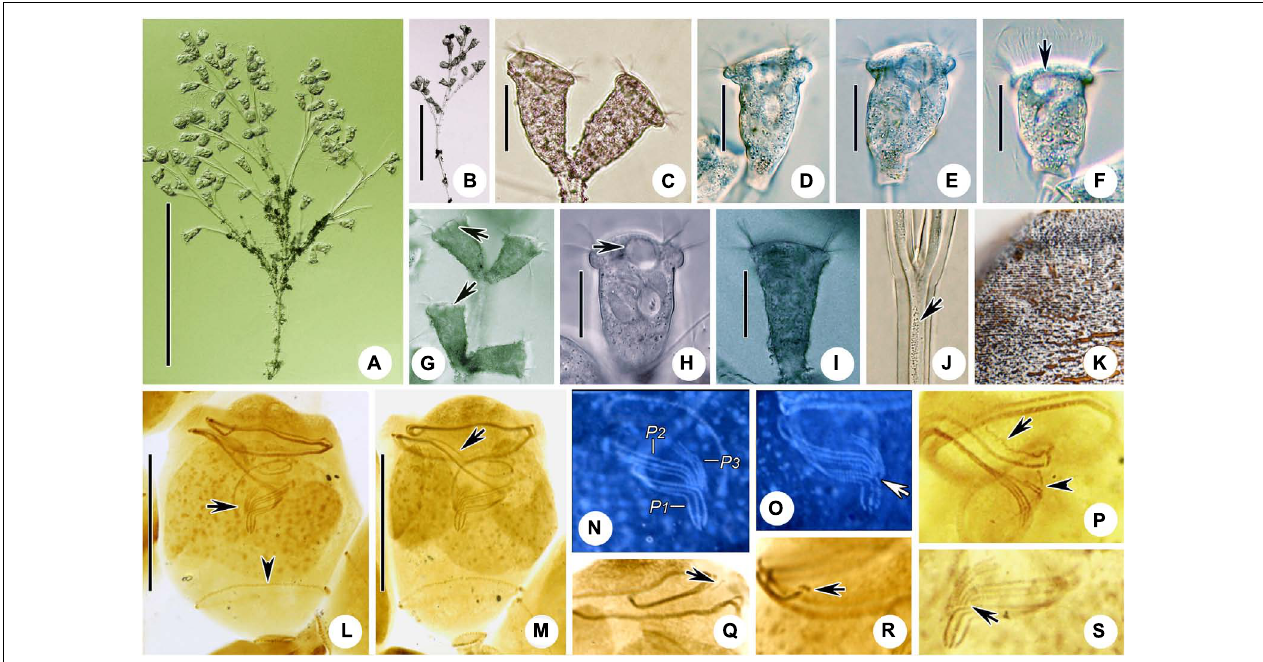
FIGURE 5 | Photomicrographs of Zoothamnium hentscheli in vivo (A–J) , after “dry” silver nitrate staining (K) , and after protargol staining (L–S) . (A) A mature colony. (B) A developing colony. (C–I) Different zooids showing the shape variation; arrows mark the contractile vacuole. (J) Detail of stalk; arrow marks the spasmoneme. (K) Silverline system. (L,M) Two protargol-stained zooids showing the ciliature; arrow in panel (L) marks the P3, arrowhead in panel (L) marks the trochal band, and arrow in panel (M) marks the germinal kinety. (N,O) Infundibular polykineties 1–3 (P1–3) (image processed by the reverse function via Photoshop); arrow marks the adstomal end of P3. (P–S) Part of the oral ciliature; arrow in panel (P) marks the germinal kinety, arrowhead in panel (P) marks the abstomal end of P2, arrow in panel (Q) marks epistomial membrane 1, arrow in panel (R) marks epistomial membrane 2, and arrow in panel (S) marks the adstomal end of P2. Bars: 500 µ m in